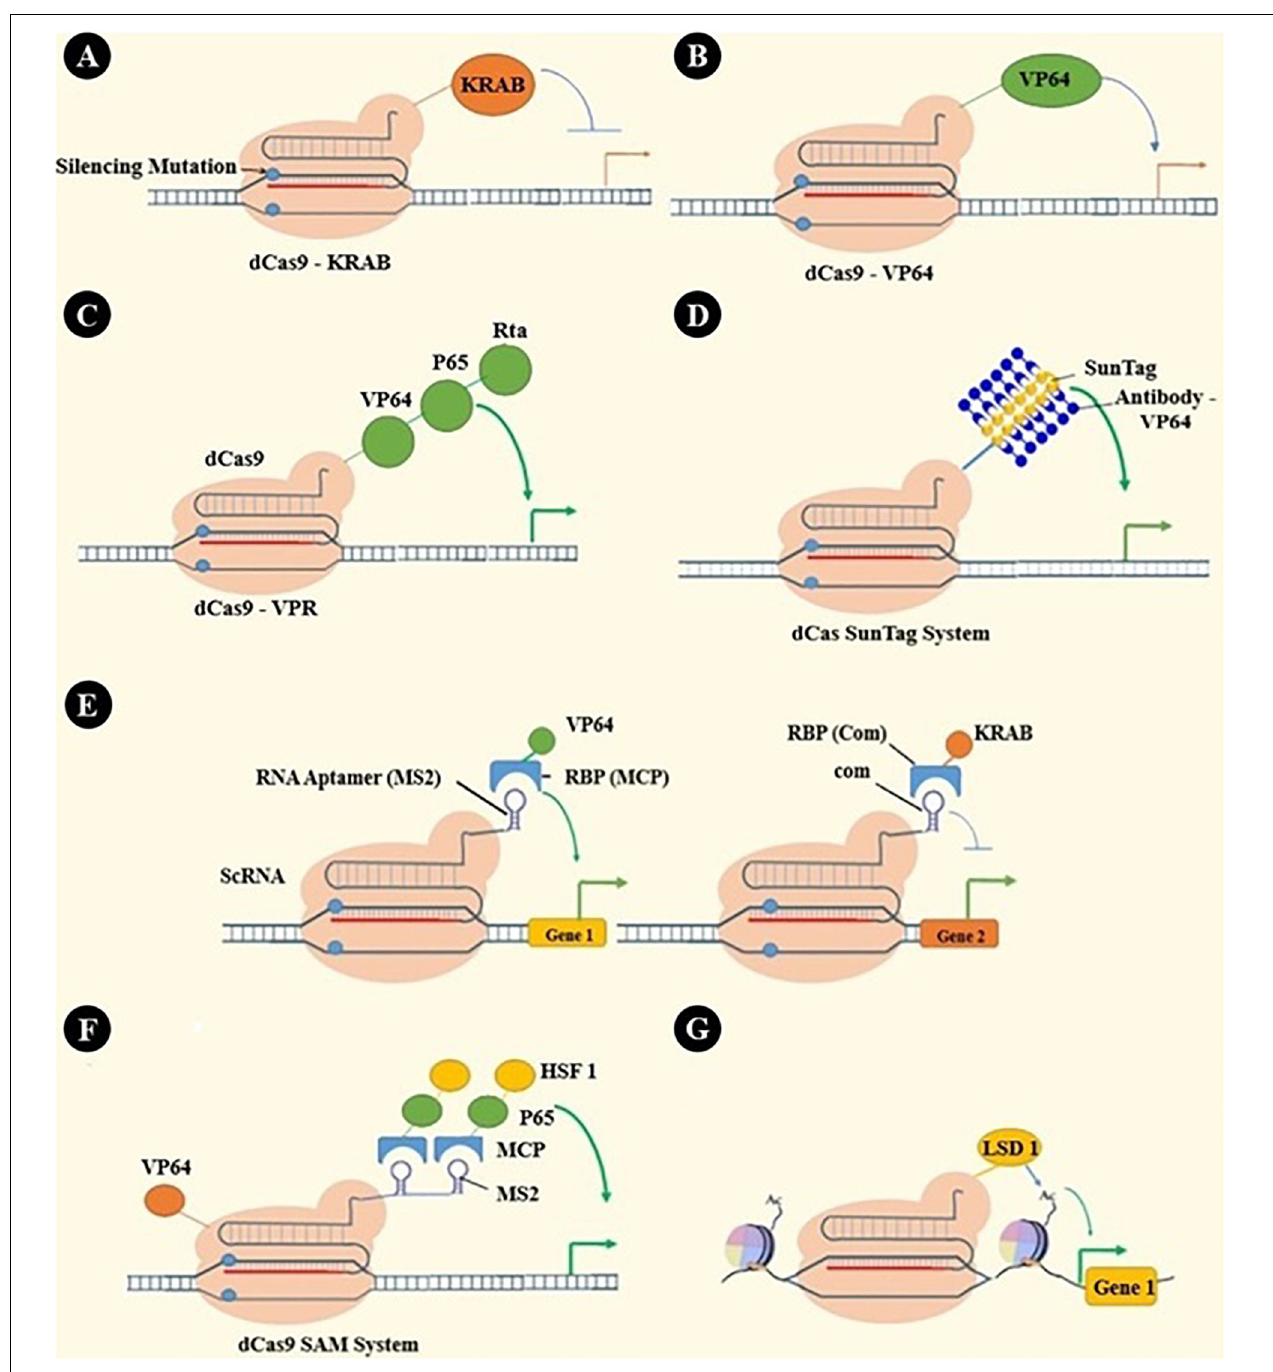
FIGURE 3 | dCas applications: beyond genome editing. (A) dCas9-KRAB has been engineered by fusing the KRAB transcription repressor domain to dCas9 (201). (B) VP64, as a transcription activator, has been fused to dCas9 to activate a specific gene’s transcription (151, 152, 202, 203). (C) Recruiting multiple transcriptional activators shows synergistic effects that have led to engineering many systems, such as VPR by in-tandem fusing of both p65 and Rta to VP64 (204). (D) SunTag is a repeating protein-peptide array that recruits multiple antibody-fusion proteins. Protein domains, such as transcriptional activating or epigenetic modulating domains, can be recruited by antibody-mediated binding to SunTag, which is fused with dCas (205, 206). (E) RNA aptamers (e.g., MS2, com, PP7) can be fused with sgRNA to create a scaffold RNA (scRNA) that can recruit RNA-binding proteins (RBPs, e.g., MCP, Com, PCP). Fusing each RBP to the effector protein has enabled gene activation, repression, or even simultaneous activation and repression in one cell (207). (F) In the synergistic activation mediator (SAM) system, effectors are recruited by both dCas and scRNA (208). (G) Epigenetic modifying enzymes like P300 and LSD1 can be fused with dCas and alter cells’ epigenomic features. These alterations were locus-specific epigenetic editing, including histone modifications and DNA methylations (205, 209, 210).